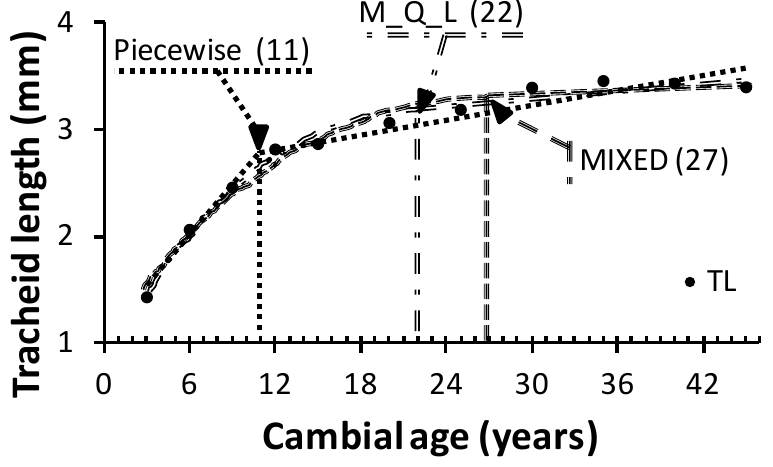
Figure 2. Mean and standard deviation of the estimates for the piecewise, maximum-quadratic-linear (M_Q_L), and MIXED model at breast height: ( a ) transition age (TA); ( b ) juvenile wood radius (JWR); ( c ) juvenile wood proportion (JWP); and ( d ) tracheid length (TL) at the time of transition.